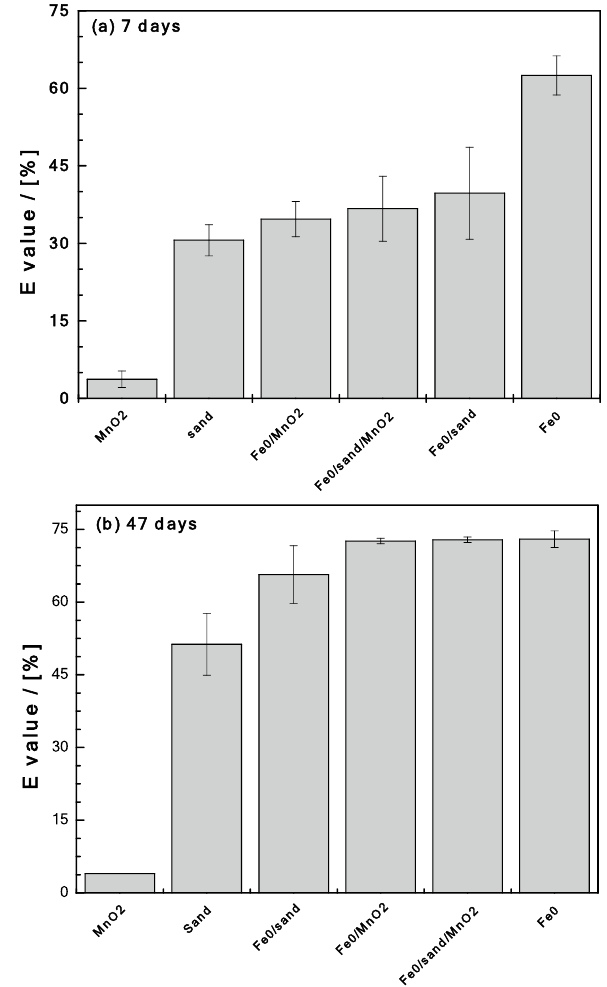
Figure 2. Comparison of the efficiency of tested materials for methylene blue (MB) discoloration for 7 ( a ) and 47 days ( b ). Experimental conditions: [Fe 0 ] = 0 to 45 g L –1 ; [sand] = 45 g L –1 ; and [MnO 2 ] = 2.3 g L –1